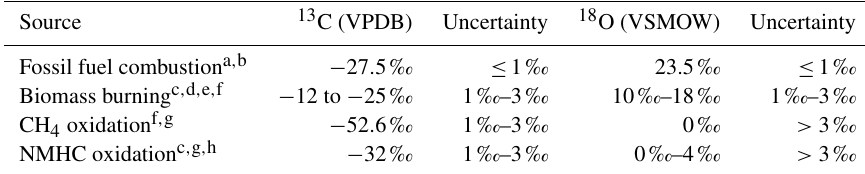
Table 1. Four main sources of CO and their isotopic source signatures. Source 13 C (VPDB) Uncertainty 18 O (VSMOW) Uncertainty Fossil fuel combustion a , b − 27 . 5‰ ≤ 1‰ 23.5‰ ≤ 1‰ Biomass burning c , d , e , f − 12 to − 25‰ 1‰–3‰ CH 4 oxidation f , g